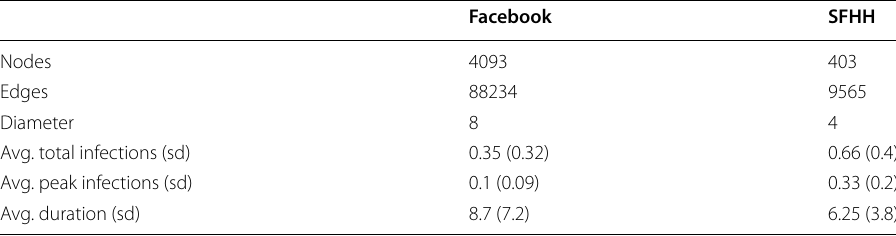
Table 1 Properties of the two real-world networks